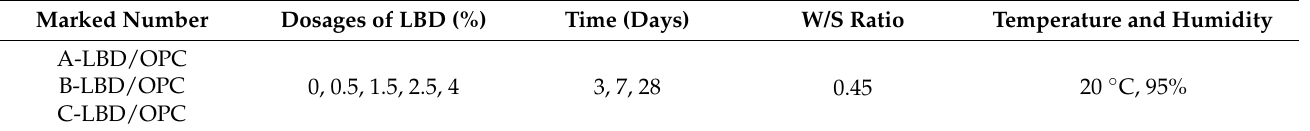
Table 2. Test samples of LBD/OPC pastes.